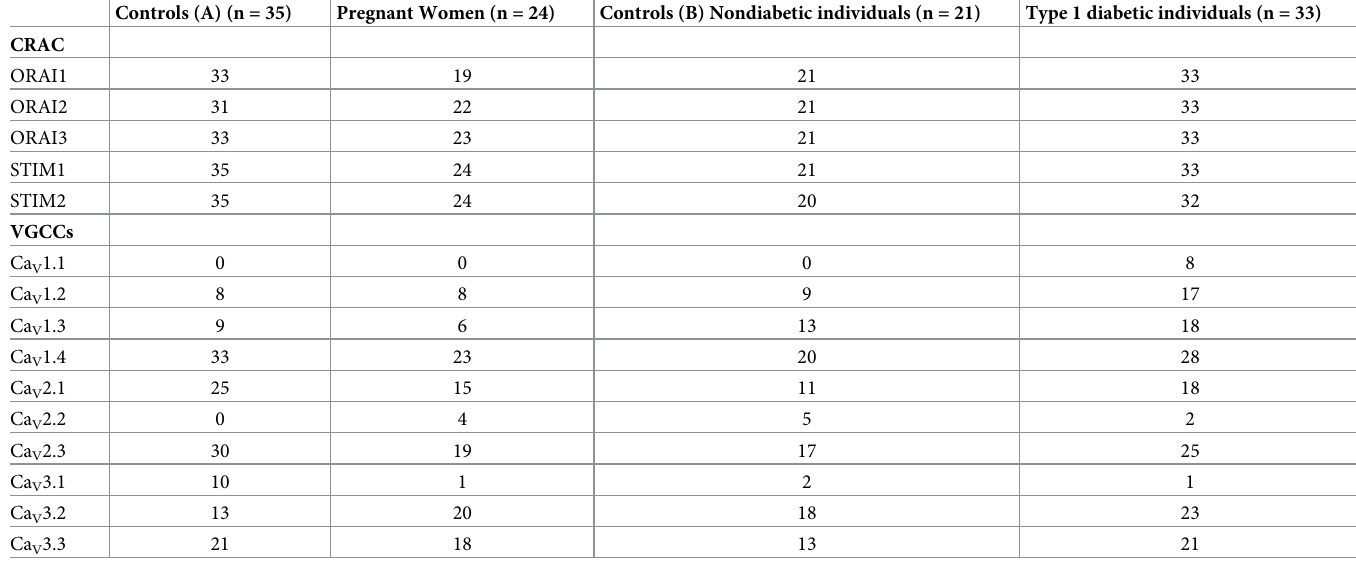
Table 1. Number of individuals expressing CRAC or Ca 2+ V channel mRNAs in PBMCs. Controls (A) (n = 35) Pregnant Women (n = 24) Controls (B) Nondiabetic individuals (n =